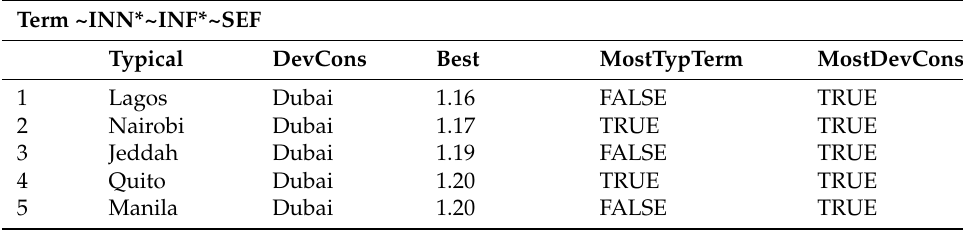
Table 13. Comparison of a typical case with a deviant case consistency